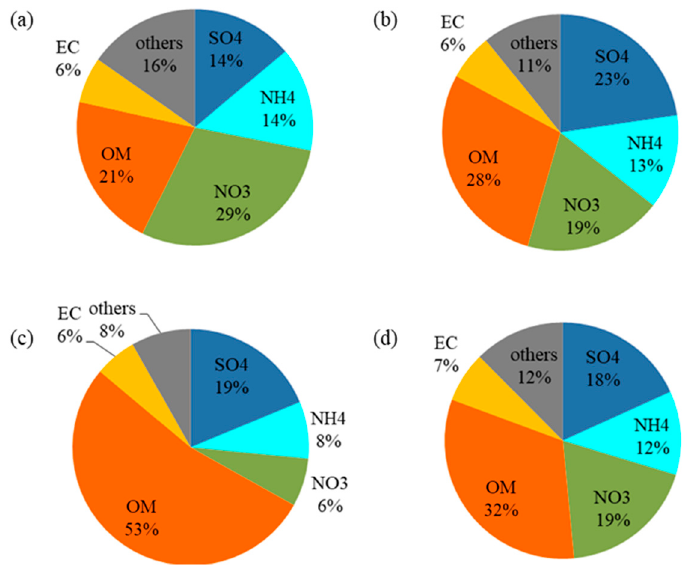
Figure 10. Modeled chemical compositions of PM 2.5 in winter ( a ), spring ( b ), summer ( c ), fall ( d ) at Seoul in 2016.